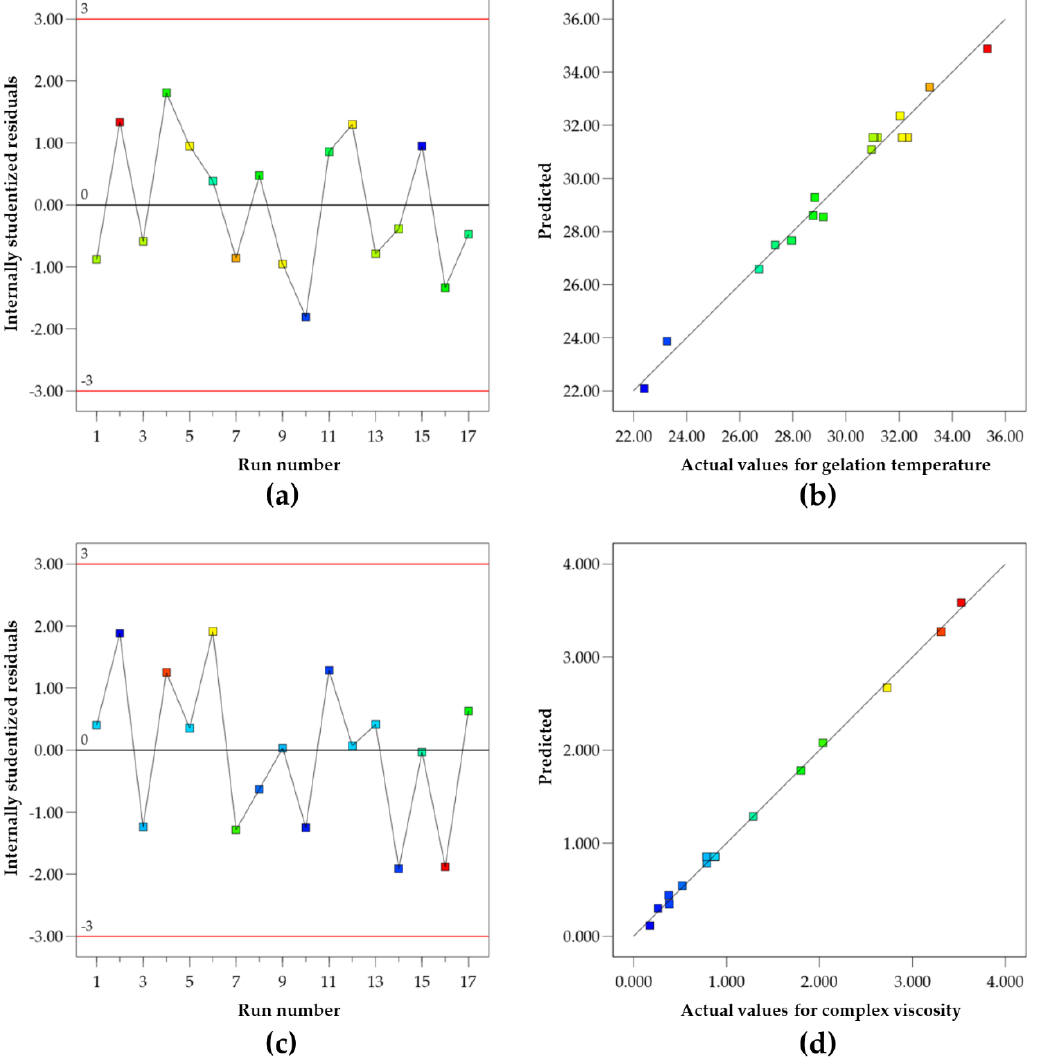
Figure 1. The residual plot between run number and internally studentized residuals for gelation temperature ( a ) and complex viscosity ( c ), and plot of predicted versus actual values for gelation temperature ( b ) and complex viscosity ( d ).